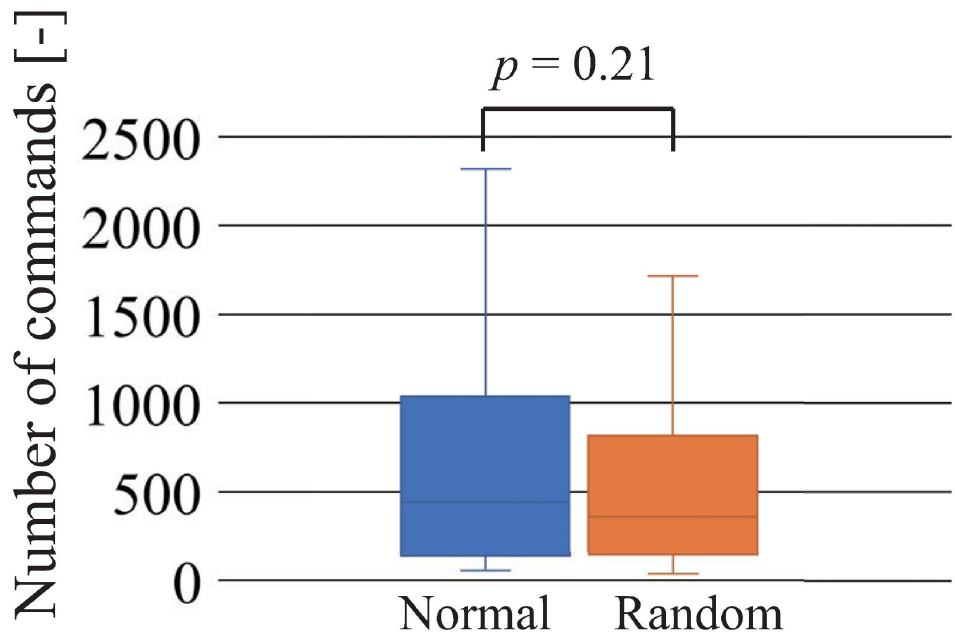
Fig 8. Number of commands required to achieve the first success of the shift task. Normal and random indicate the normal and random controllers, respectively.